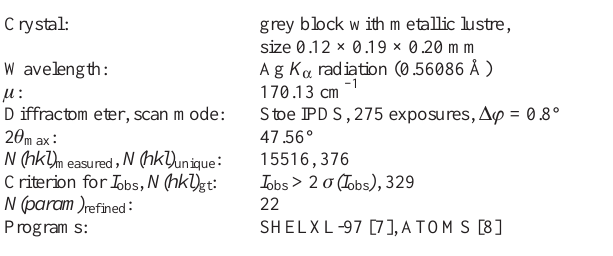
Table 3. Data collection and handling.